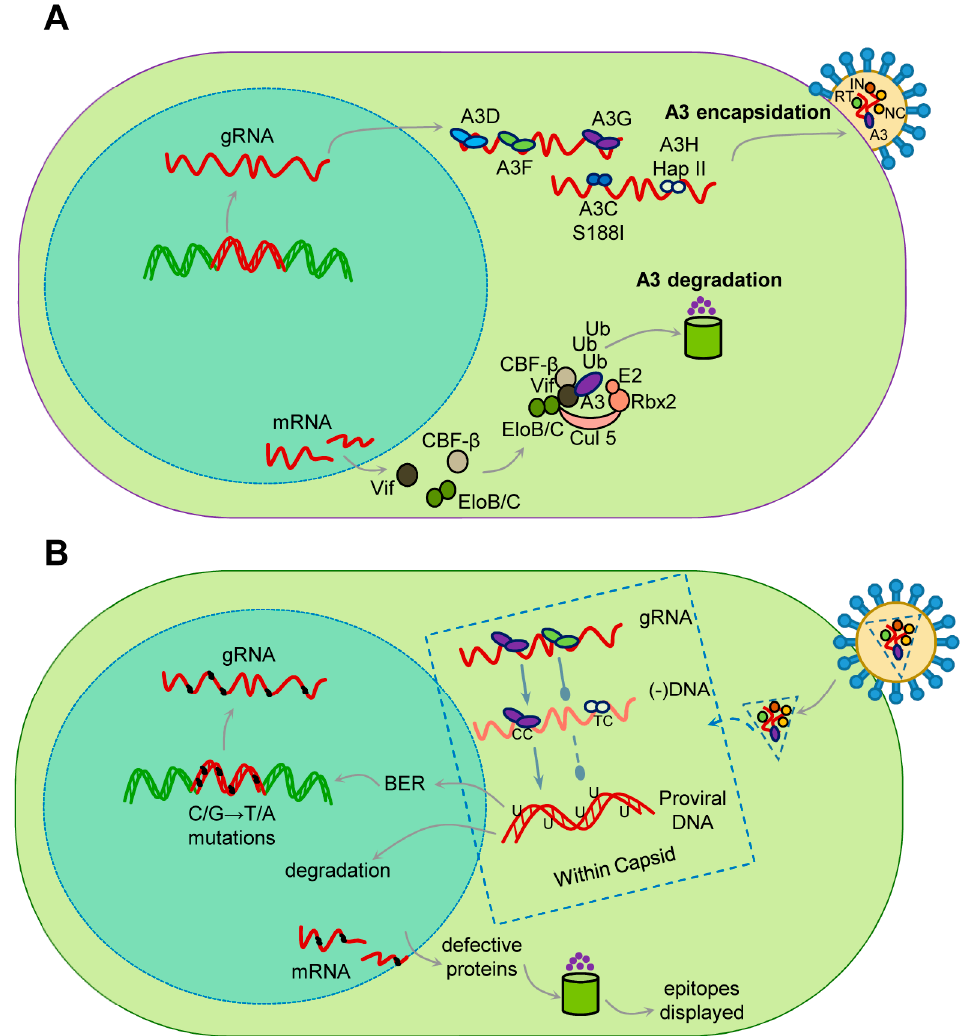
Figure 1. APOBEC3-mediated restriction of HIV-1 and Vif counteraction. ( A ) An HIV or SIV retrovirus integrates into the host genome as a double-stranded DNA provirus (red). This provirus is transcribed to produce genomic RNA (gRNA) and mRNA. The gRNA is exported to the cytoplasm where it is bound by viral Gag polyprotein to facilitate encapsidation (not shown). Additionally, in the cytoplasm are the APOBEC3 (A3) enzymes A3D, A3F, A3G, A3C S188I, and A3H Haplotypes II, V, and VII. The A3 enzymes bind the gRNA and become encapsidated if they escape Vif mediated degradation. There are also the viral proteins reverse transcriptase (RT), nucleocapsid (NC), integrase (IN) among others, with the encapsidated A3. The viral mRNA produces the protein Vif later in the replication cycle and with the highest Vif levels correlating with virus assembly, to purge the cytoplasm of A3 enzymes. However, Vif-mediated degradation is often incomplete. Vif binds CBF- β and Elongin C (EloC) which stabilizes Vif and enables nucleation of the Cullin 5 E3 ubiquitin ligase complex which ubiqutinates A3 enzymes and induces their degradation through the proteasome pathway. ( B ) A3 enzymes that escape this fate travel to the next target cell of infection within the viral capsid. The capsid stays intact during reverse transcription and is drawn as an expanded view in a box. Here the viral reverse transcriptase copies the gRNA to (-)DNA. This forms a RNA/DNA hybrid (not shown) that is converted to ssDNA by the endonuclease action of the RNaseH domain of reverse transcriptase. During this short time before (+)DNA synthesis starts, A3 enzymes access ssDNA and inhibit reverse transcriptase DNA synthesis from the RNA (round head arrow) or DNA (hatched round head arrow) template, but the blockage is more efficient from the RNA template. Primarily the A3 enzymes deaminate cytosine (C) → uracil (U) in a 5’CC or 5’TC context. Copying a U in DNA leads to an adenine (A) being inserted on the (+)DNA strand. This causes G → A mutations in the coding strand sense. The uracils can be repaired by host base excision repair (BER) and the proviral DNA can integrate into the